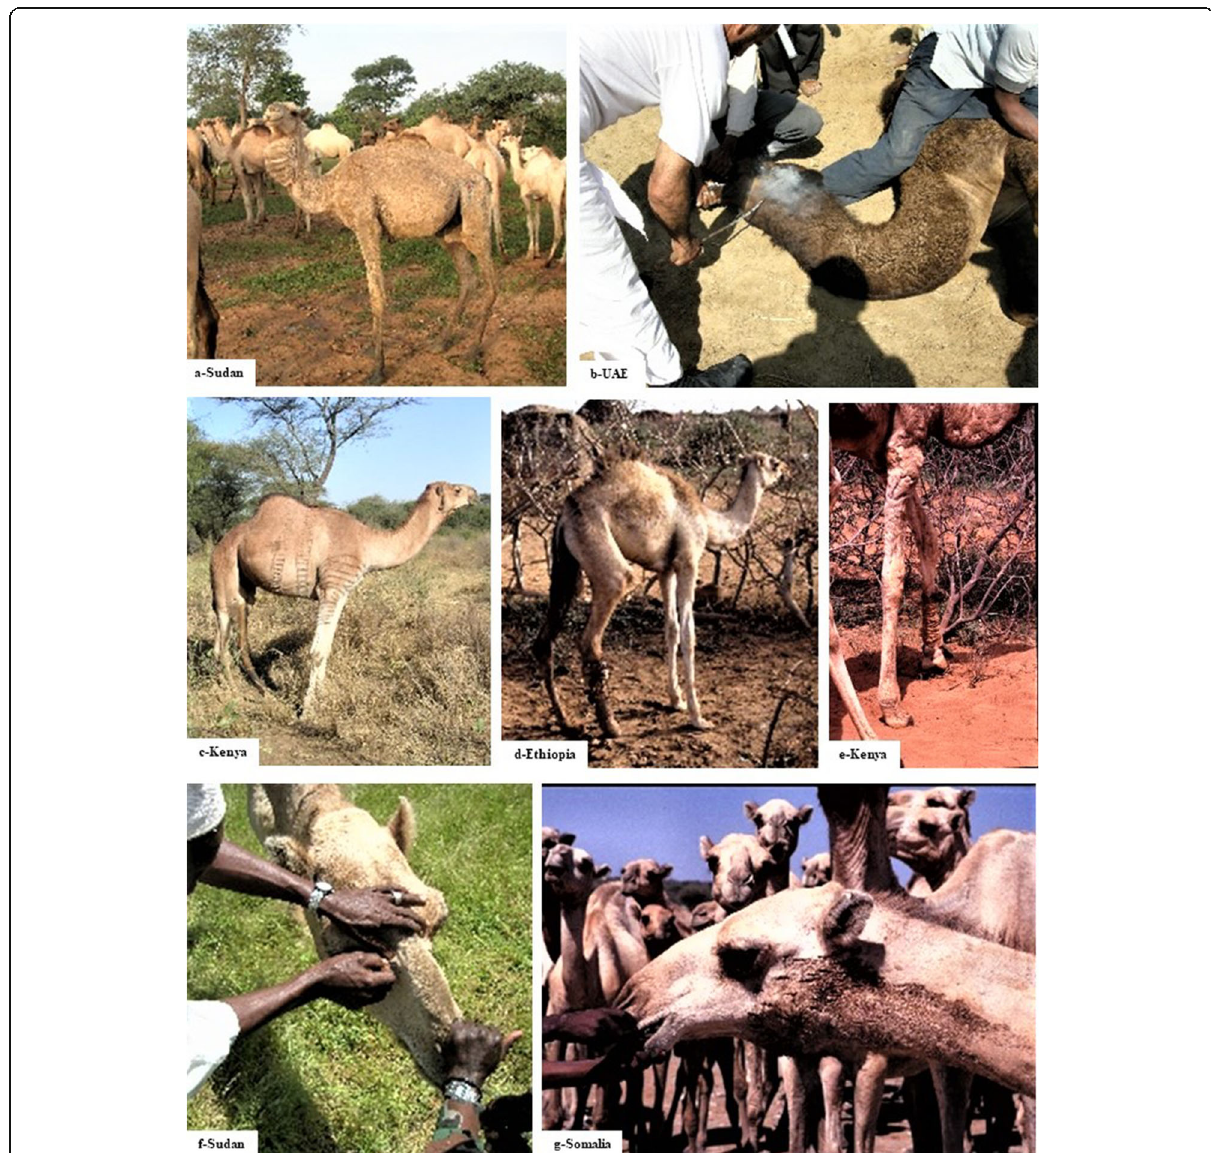
Fig. 13 Images of various ethnoveterinary treatments used by nomadic camel pastoralists in a variety of countries (Dioli 2012,2013, Schwartz and Dioli 1992). a , f Sudan. b UAE. c , e Kenya. d Ethiopia. f Sudan. g